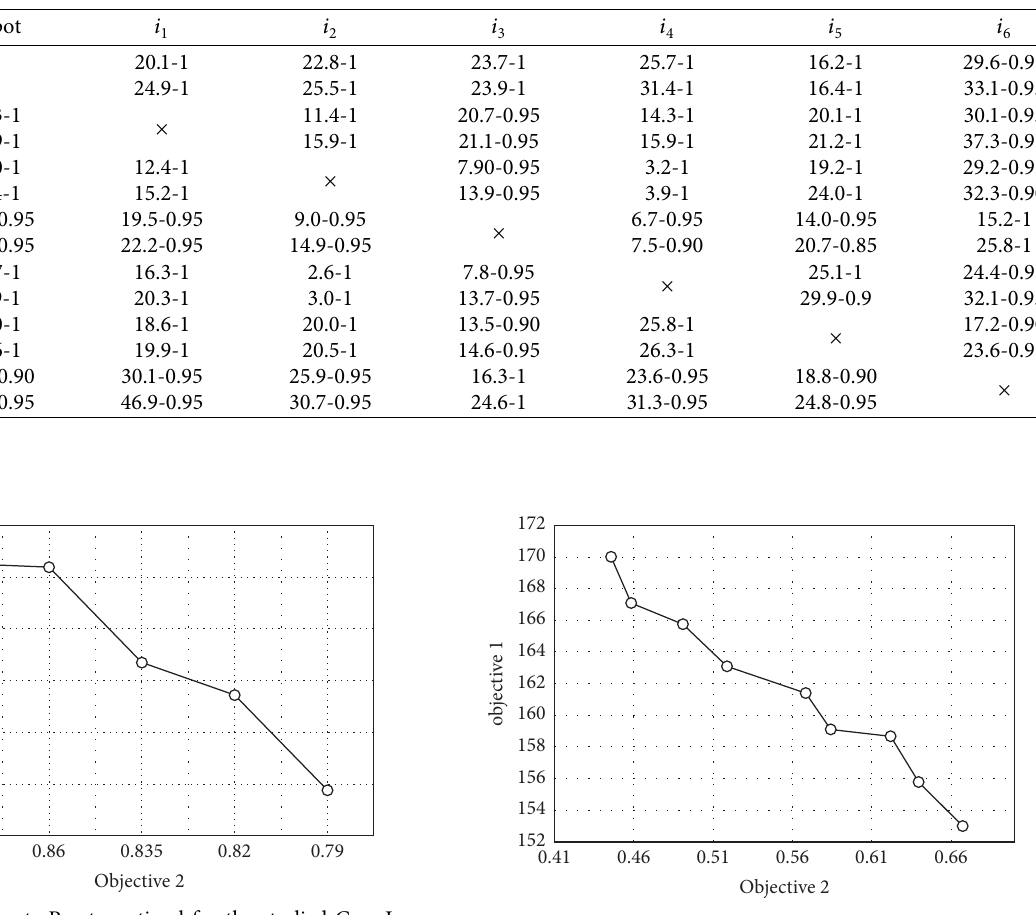
Figure 13: (a) Speed changes of the light traffic zone; (b) speed changes of the medium traffic zone; (c) speed changes of the heavy traffic zone (continues line: first scenario; dash line: second scenario). Table 8: Details of distances (km) for two parallel links between main shelter locations in multigraph.